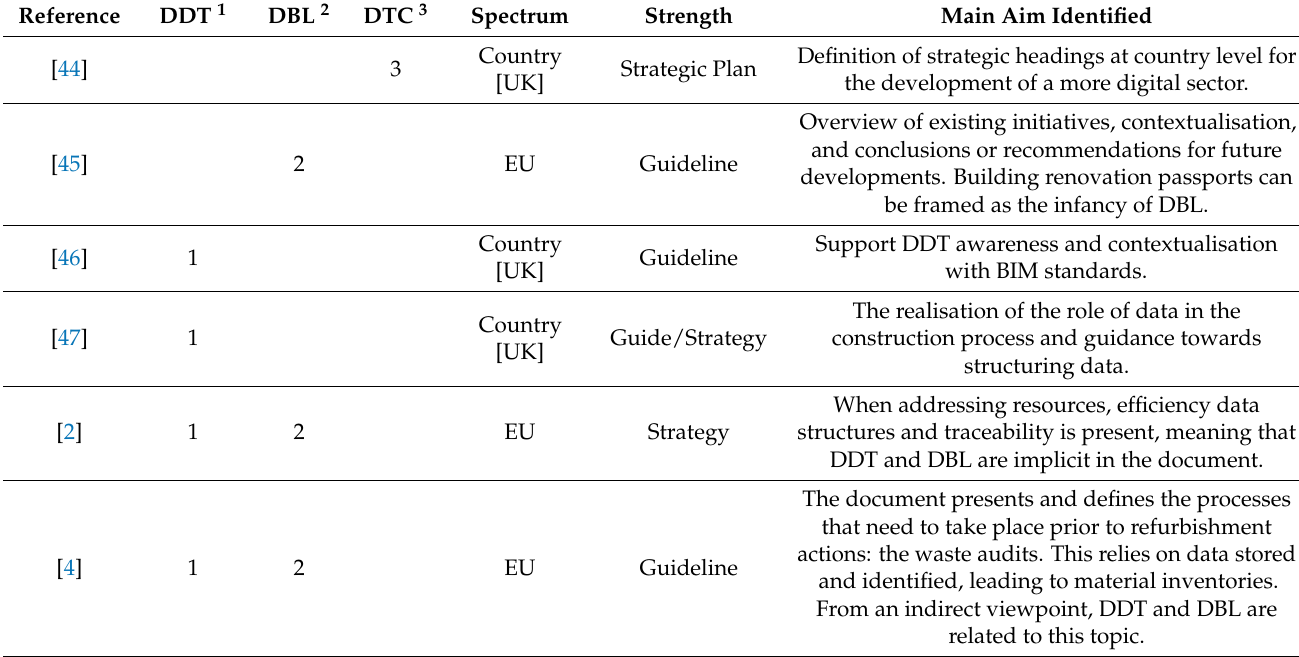
Table 4. The content of the selected publications (selected by the authors), in terms of the digital solutions implemented (DDT—digital data templates—1; DBL—digital building logbook—2; DTC—digital twin construction—3), spectrum of research (world, EU, country, sector, subsector), strength (law, standard, guideline, strategy), and the main research aims